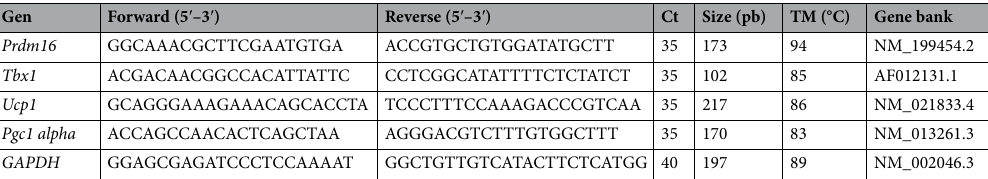
Table 1. primer pair sequence are shown for the Forward (F) and Reverse (R) primers used to measure mRNA abundance by